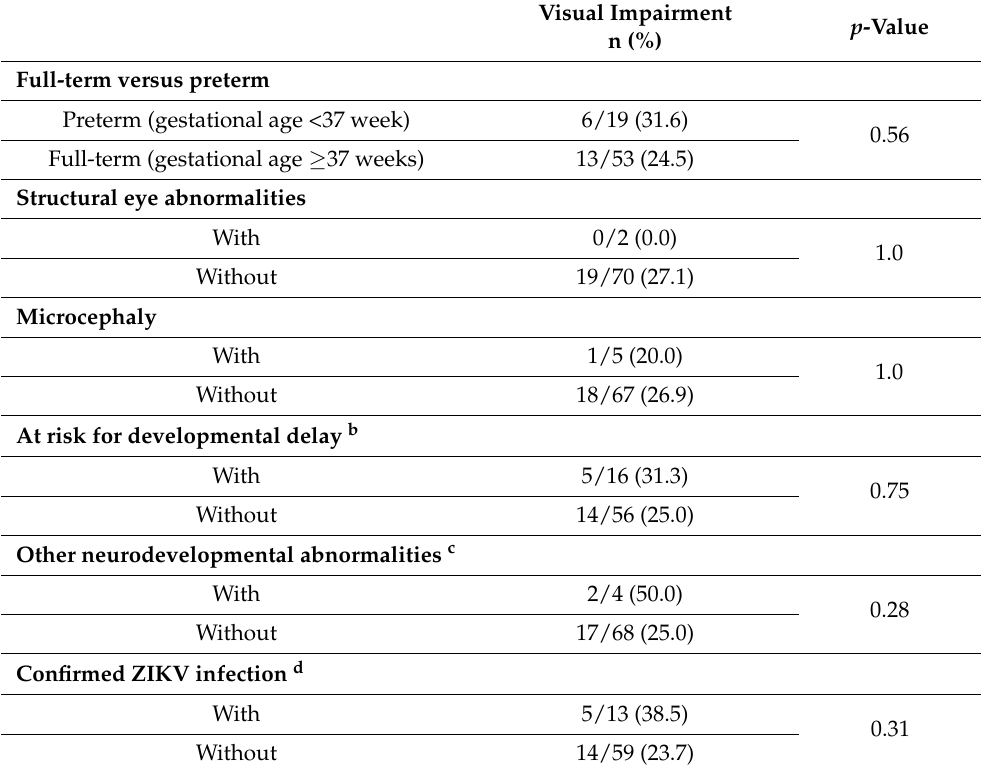
Table 4. Comparison of the proportion of children with visual impairment by gestational age and other clinical characteristics a